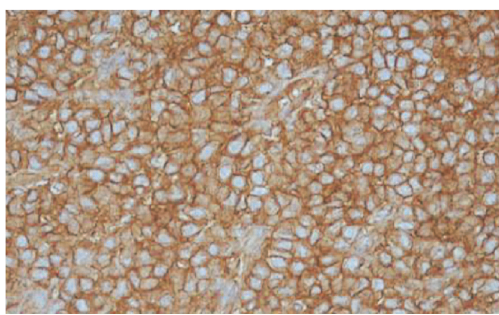
Figure 3: Immunohistochemistryof tumour sample showing CD99